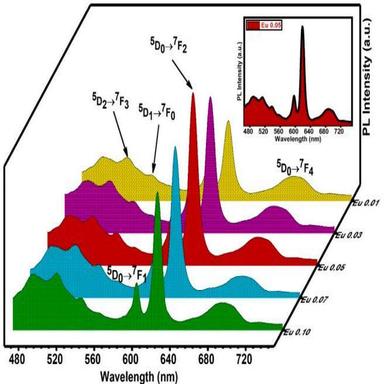
PL emission spectra of Eu3+ activated Ba2La4Zn2O10 nanophosphor recorded at λex = 394 nm.